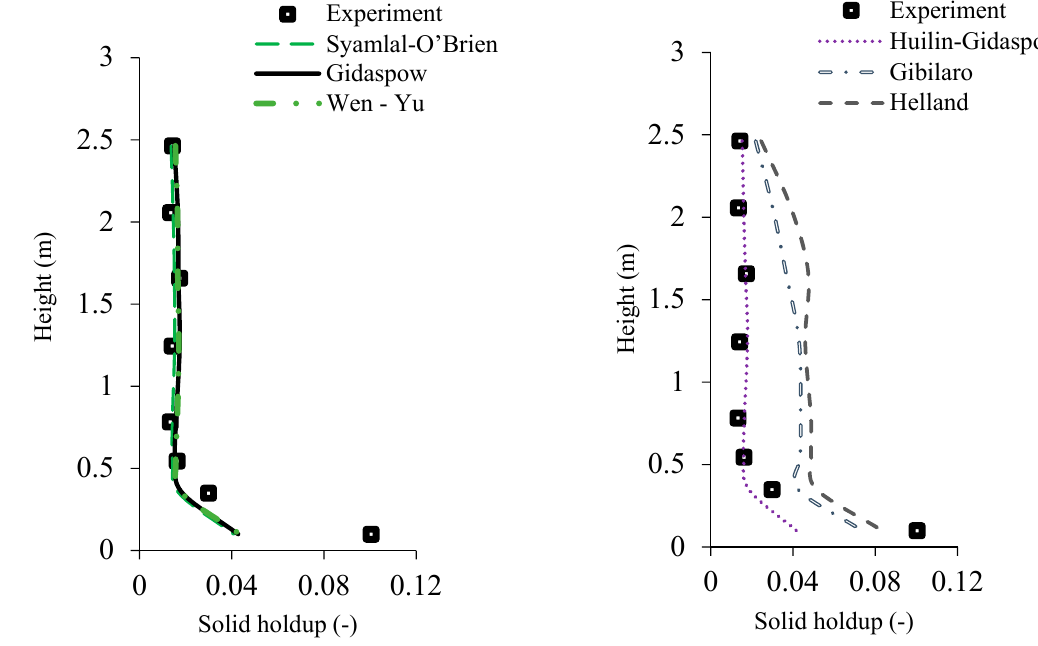
Figure 6. Influence of drag models on the axial solid holdup profile.